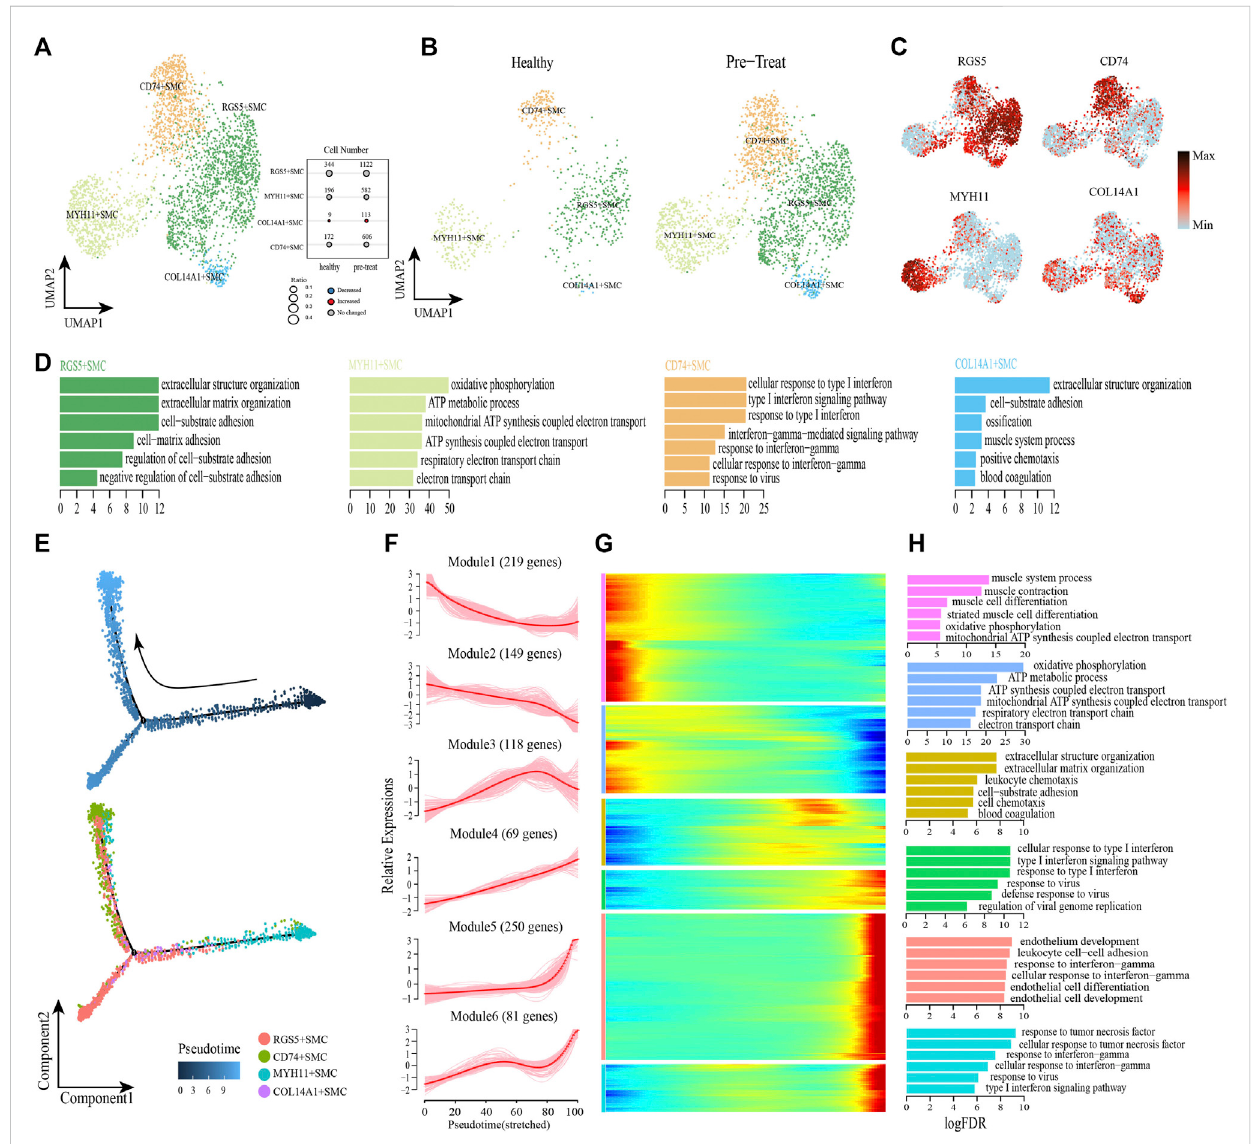
FIGURE 6 Gene expression pro fi le analysis of smooth muscle cells in JDM patients. (A,B) Visualization of smooth muscle cell sub-clusters in human muscle sample via UniformManifoldApproximationandProjection(UMAP)plotsbycellidentity (A) anddifferentstages (B) . (C) Thefeatureplotsofmarkergenes of smooth muscle cell sub-clusters. (D) GO enrichment analyses of marker genes of smooth muscle cell sub-clusters. (E) Pseudotime trajectory (Monocle analysis) of the smooth muscle cells. Cells are colored based according to the predicted pseudotime (top) and groups (bottom). (F) The expressiondynamicsoftopDEGswerecatalogedintosixmajorclustersinapseudotimemanner. (G) GeneexpressionheatmapoftopDEGs(catalogedin six clusters) in a pseudo-temporal order. (H) GO enrichment analyses of each gene